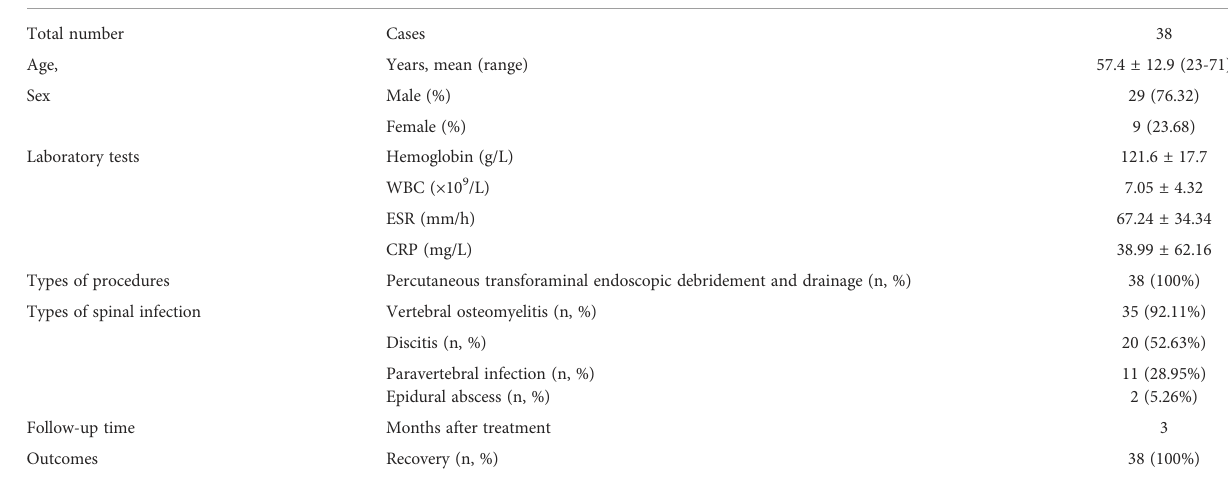
TABLE 1 Demographic characteristic of the patients with spinal infection.